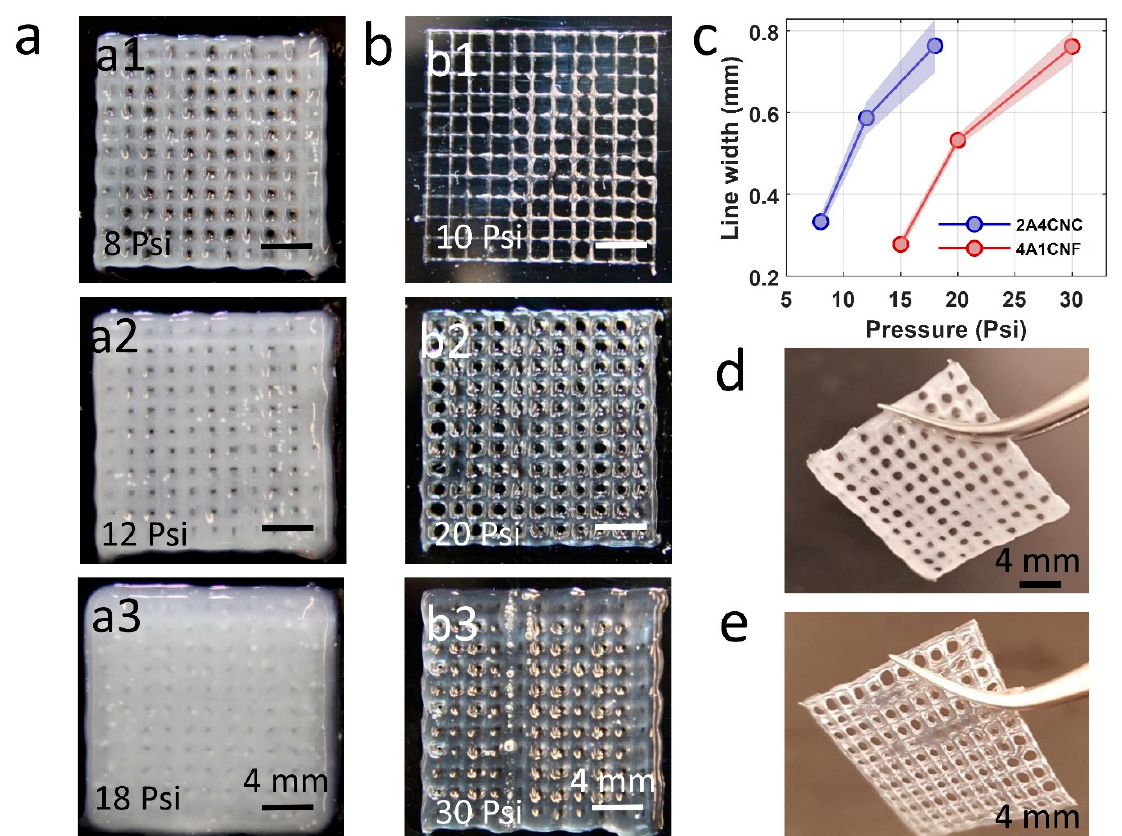
Figure 2. Printability of two hybrid bioink formulations using custom-made bioprinter. ( a ) Representative images of 3D printed 16-layers and 20 × 20 mm square grid pattern for 2A4CNC (2% Alginate and 4% Cellulose Nanocrystals) bioink. Three different air pressures were tested to find optimum pneumatic air pressure. ( b ) Representative images of 3D printed grid pattern with 4A1CNF (4% Alginate and 1% TEMPO oxidized Cellulose Nanofiber) under three different air pressures. ( c ) Line thickness printed by extrusion at various air pressures, showing the effect of air pressure on the filament width. ( d ) Representative images of 2-layers grid pattern after 2 min crosslinking in calcium with an optimum air pressure of 12 PSI for 2A4CNC bioink and ( e ) optimum air pressure of 20 PSI for 4A1CNF.